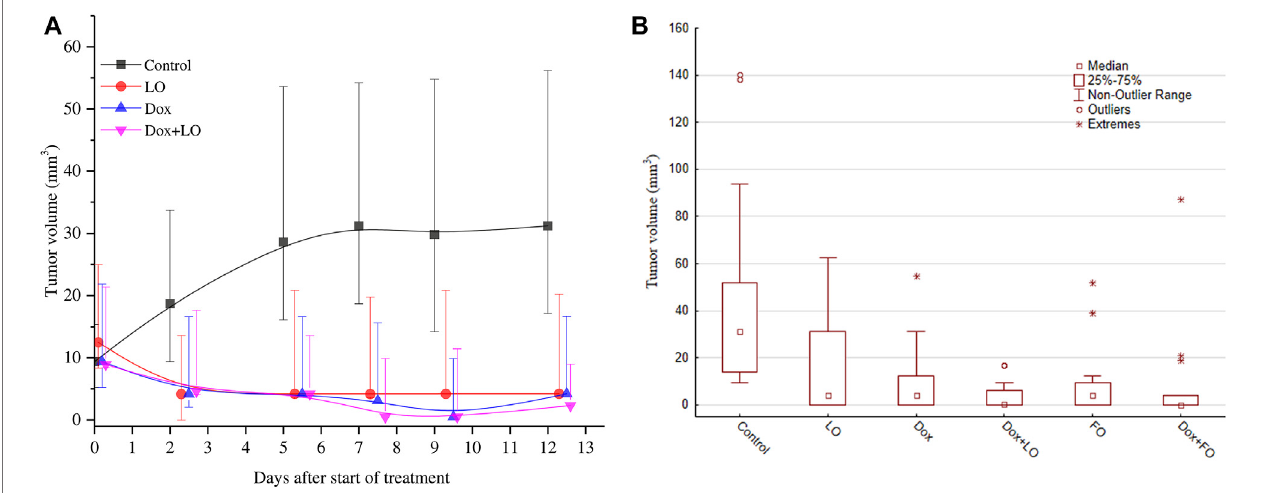
FIGURE 4 | The dynamics changes of LLC tumor volume over the whole course of treatment (A) ; the tumor volume 12 days after the start of treatment (B) . The results are obtained for all the studied groups in two independent experiments. The data is presented as the median and the values of the upper and lower quartile.